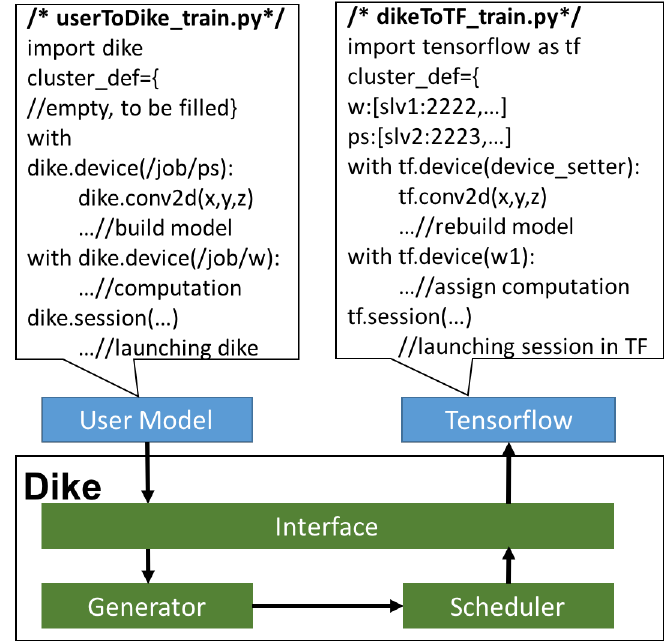
Figure 1. Architecture of